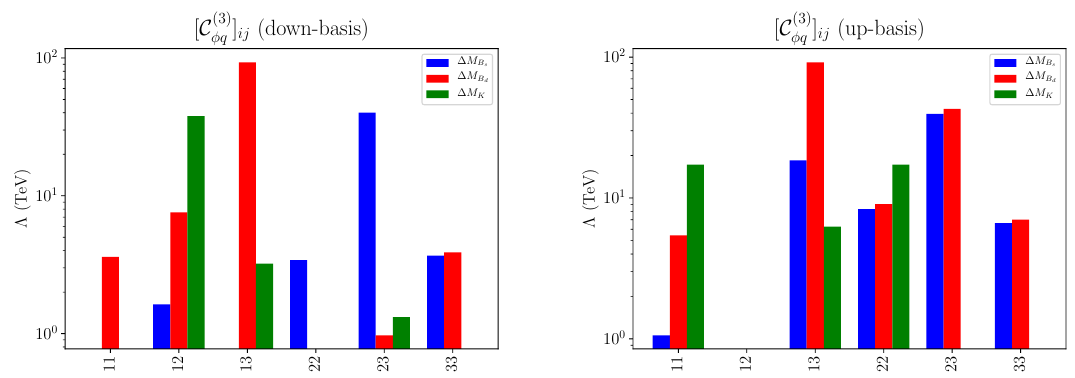
(cid:2) (cid:3) c (3) = 10 that corresponds to a 10% effect in φq ij